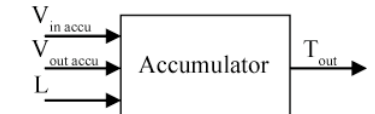
Accumulator carriage velocity